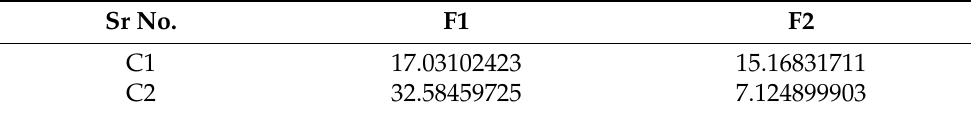
Table 12. The best centroids for Jain obtained by proposed approach.